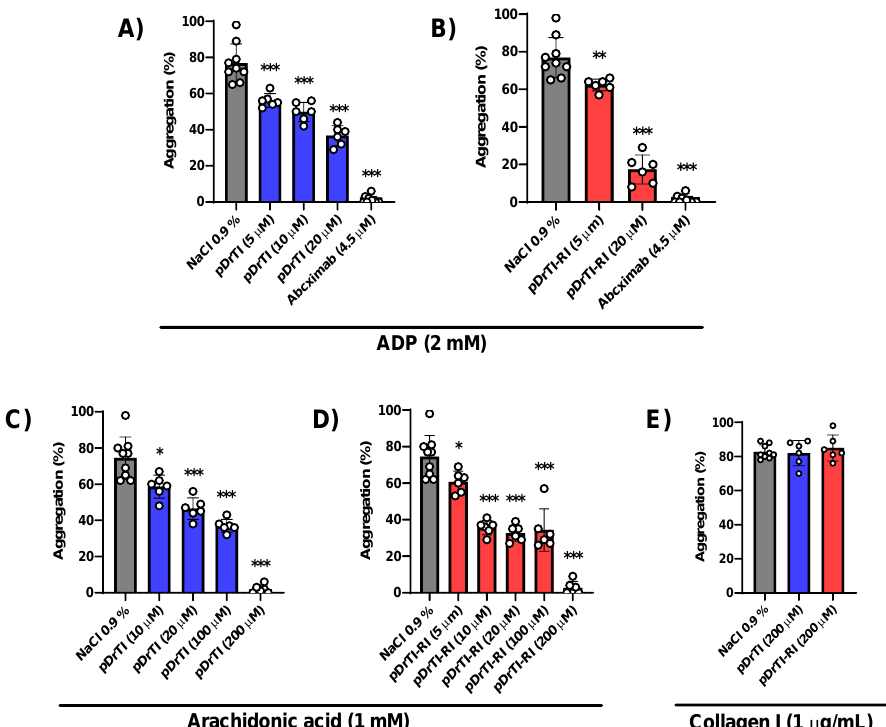
Figure 3. Platelet Aggregation—PRP was obtained from healthy individuals. Different concentrations of the peptides were added to the PRP and incubated at 37 °C for 5 min. After the incubation time, the agonist (ADP, arachidonic acid, or collagen I) was added and the reaction was monitored in an automatic aggregometer Chrono-log 700 through transmittance/impedance. Assays were performed in triplicate. Results are shown as percentage aggregation, ADP induced aggregation was inhibited by pDrTI ( A ) and pDrTI-RI ( B ); Arachidonic acid induced aggregation was inhibited by pDrTI ( C ) and pDrTI-RI ( D ) and collagen I induced aggregation was not inhibited ( E ). Statistical analysis was made using one-way ANOVA with Welch’s correction using GraphPad Prism 8. n.s.: non-significant; * p < 0.05; ** p < 0.01; *** p < 0.001.